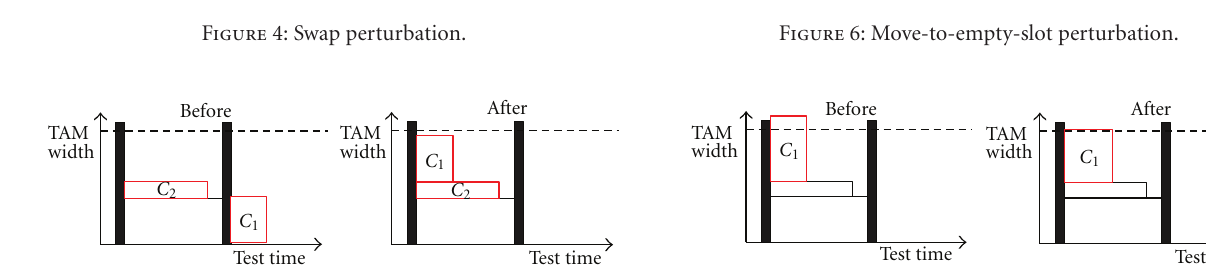
Figure 4: Swap perturbation.